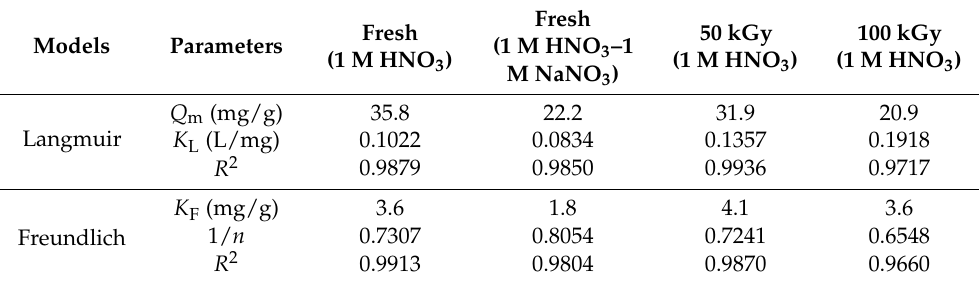
Figure 8C,D show the adsorption isotherm model fitting curves of N3/SiO 2 to Re at different absorbed doses. It can be observed that as the absorbed dose increased from 50 to 20.9 mg/g, consistent with the results of the acidity experiment. The adsorption capacity